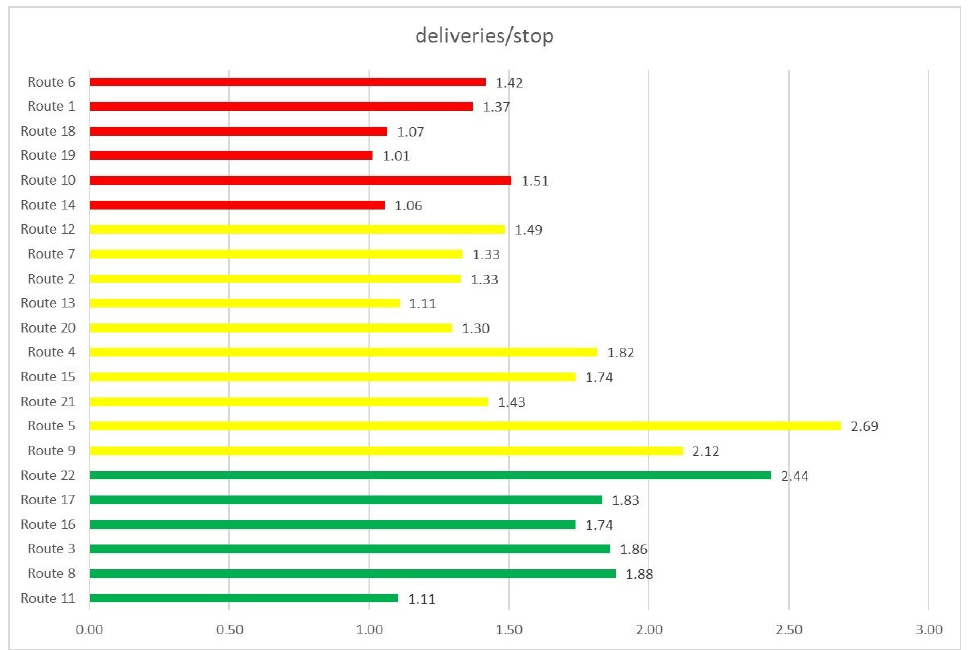
Figure 8. Delivery performance vs. customers (recipients) at particular route. Colors represents: green—group A, yellow—group B, red—group C Source: Own study.